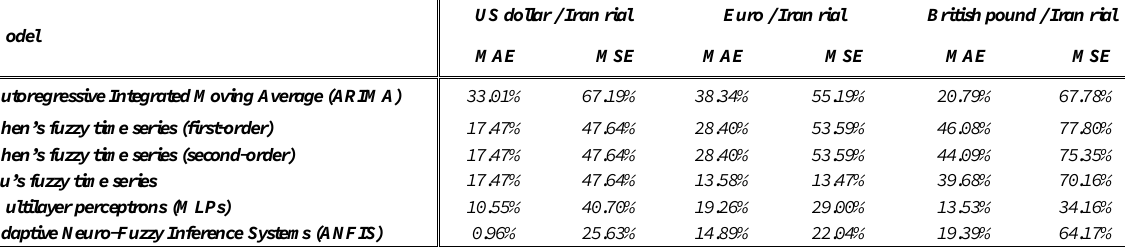
Table 8. Improvement percentage of the proposed model in comparison with those of other forecasting models in point